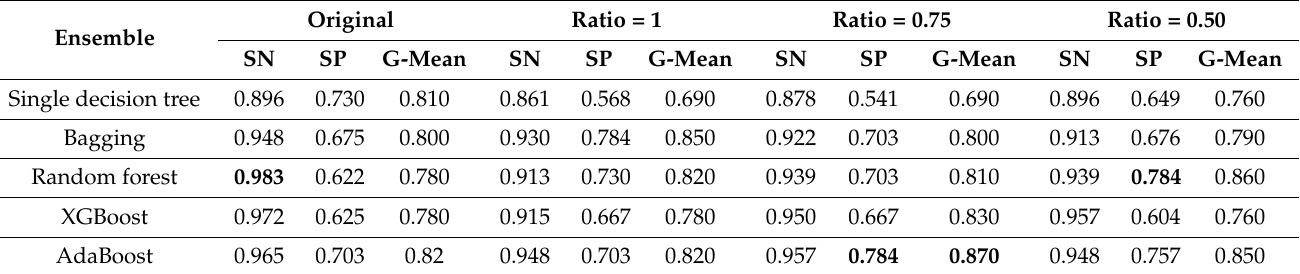
Table 4. The performance metric of ensembles (standard decision tree) along with oversampling method (SMOTE) of minority and majority class points for different ratios. SN, SP, and G-Mean performance metrics are considered for this experiment. (Best results are shown in bold